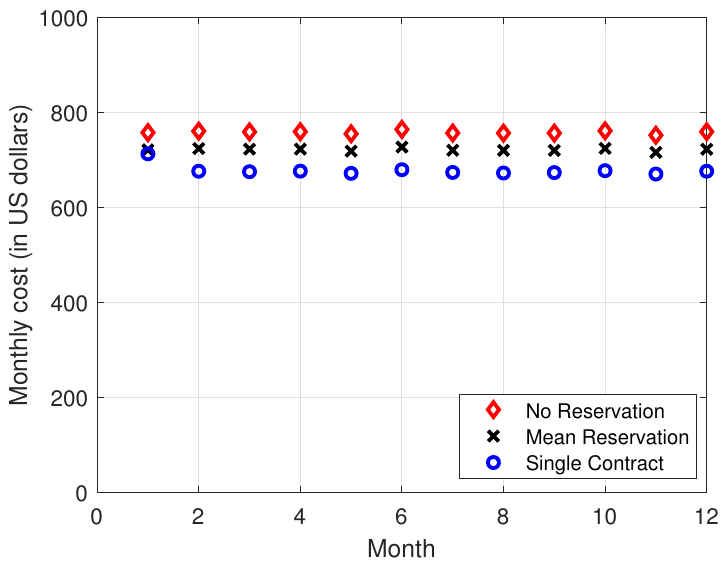
Figure 4. Monthly cost vs. month. The demand traffic is modeled as an exponential stochastic process with mean = 4000 VMs. Monthly cost (in USD).